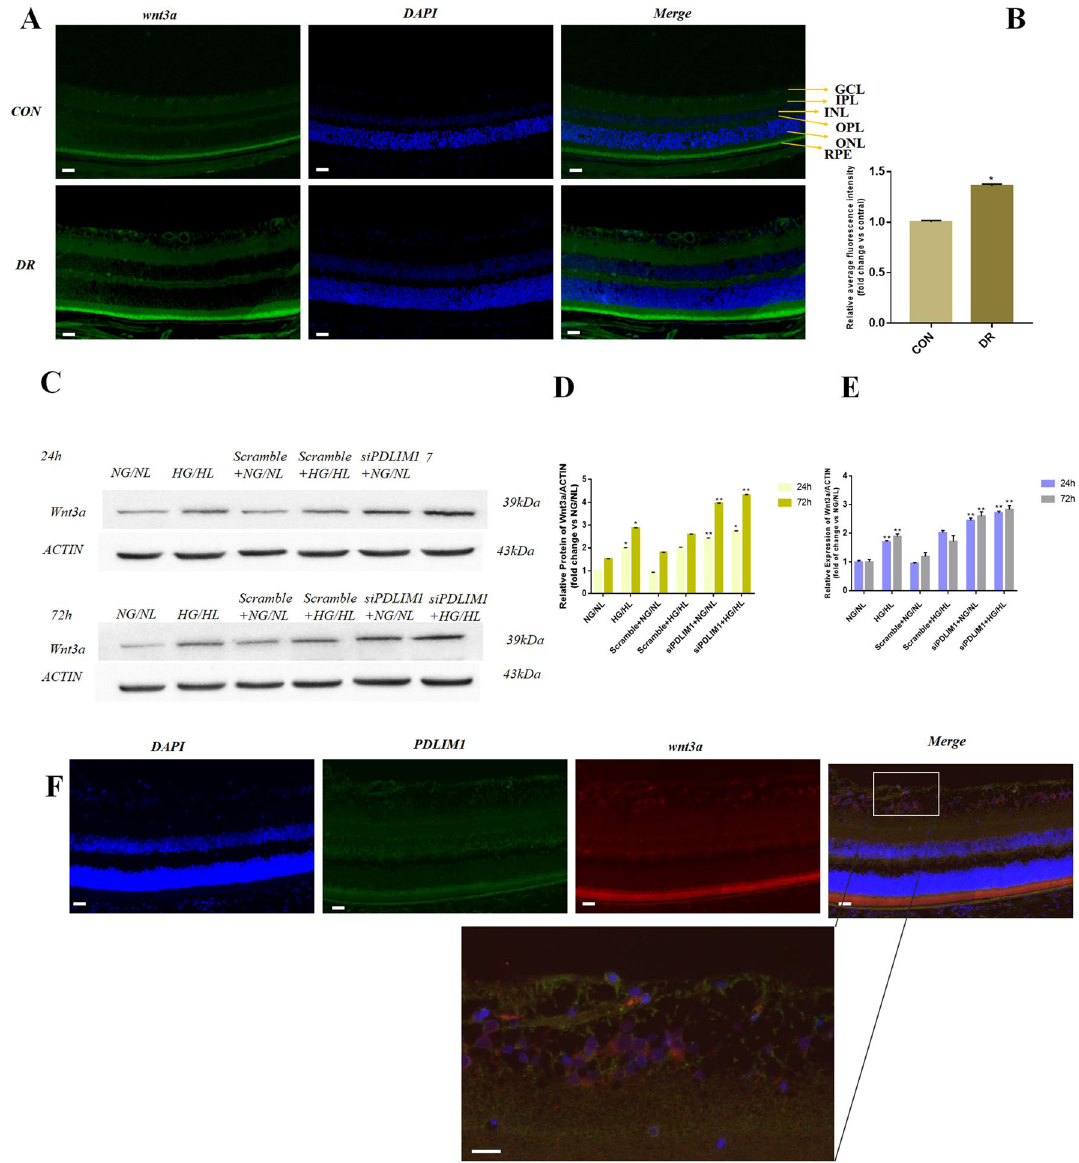
Figure 2. The expression of Wnt3a in mouse retina and retinal capillary endothelial cells (RCECs). ( A ) Immunofluorescence staining showed that Wnt3a was mainly expressed in the retinal pigment epithelium (RPE) layer, ganglion cell layer (GCL), the inner plexus (IPL) and outer plexus layer (OPL). Scale bar: 100 μm. ( B ) Semi-quantitative analysis showed that Wnt3a expression increased in DR mice. ( C ) Representative immunoblots showed that the protein expression of Wnt3a increased after HG/HL treatment and PDLIM1 knockdown. ( D ) Wnt3a protein level increased at 24 h/72 h in HG/HL compared with NG/NL. After PDLIM1 knockdown, the expression of Wnt3a increased at 24 h/72 h in RCECs, compared with scramble control. ( E ) The mRNA expression of Wnt3a upregulated at 24 h/72 h in HG/HL, compared with NG/NL. Wnt3a mRNA increased after PDLIM1 knockdown at 24 h/72 h, compared with scramble control. ( F ) Double staining of PDLIM1 and Wnt3a in the retina showed that the expression location of PDLIM1 and Wnt3a was basically the same, in which green was PDLIM1 and red was Wnt3a. ( CON: control group, DR: diabetic retinopathy, GCL: ganglion cell layer, IPL: inner plexiform layer, INL: inner nuclear layer, OPL: outer plexiform layer, ONL: outer nuclear layer, RPE: retinal pigment epithelium). *P < 0.05, **P <